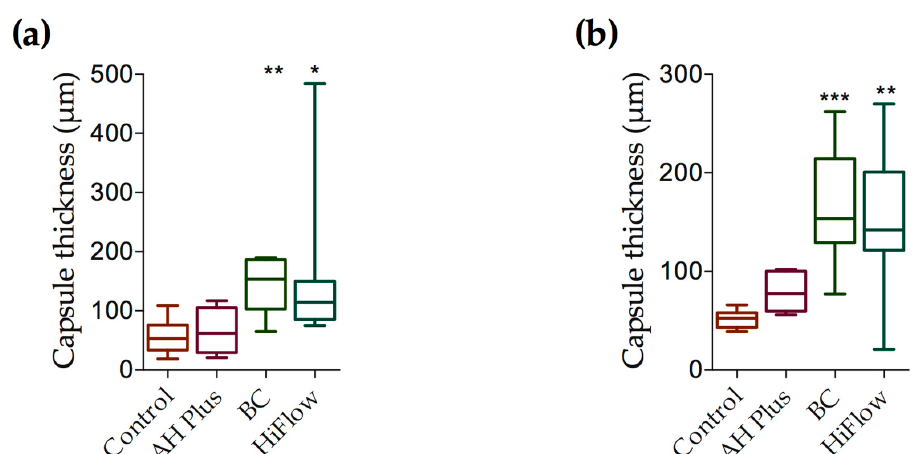
Figure 4. Fibrous capsule thickness ( µ m) at 8 and 30 days. ( a ) Fibrous capsule at 8 days comparing control to AH Plus, BC and HiFlow groups. Control n = 8; AH Plus n = 8; BC n = 8; HiFlow n = 8 ( b ) Fibrous capsule thickness at 30 days. Control n = 8; AH Plus n = 8; BC n = 8; HiFlow n = 8. Kruskal–Wallis test with Dunn’s post hoc test for multiple comparisons * p ≤ 0.05, ** p ≤ 0.01, *** p ≤ 0.001. Data are presented as means ± SEM.